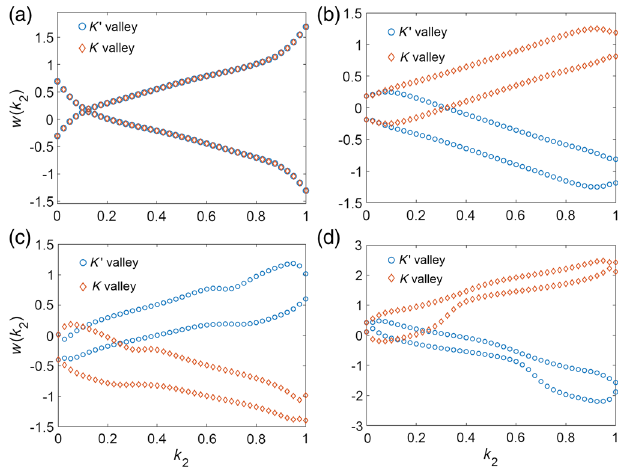
FIG. 4. The Wilson loops of ( M þ N )-layer twisted multilayer graphene at the first magic angle θ ¼ 1 . 05 °. (a) M ¼ 2 , N ¼ 2 with the same stacking chiralities, (b) M ¼ 2 , N ¼ 2 , with opposite stacking chiralities, (c) M ¼ 2 , N ¼ 4 , with the same stacking chiralities, and (d) M ¼ 2 , N ¼ 4 , with opposite stack- ing